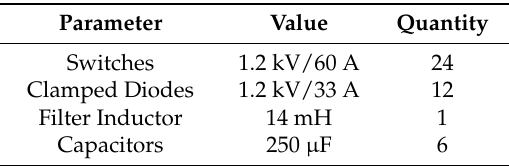
Table 1. Parameter specifications of the NPC